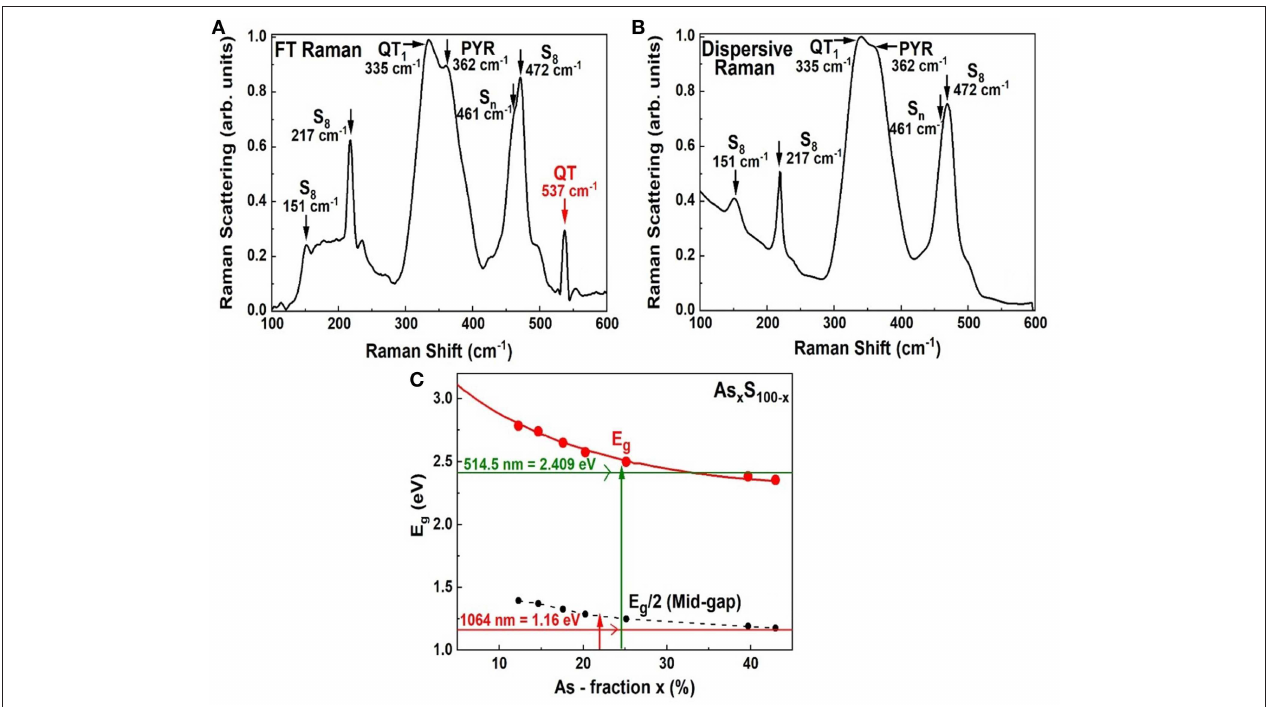
FIGURE 10 | Showing (A) FT—Raman spectrum of an As 18 S 82 glass as in Figure 4F , (B) a Dispersive Raman spectrum of the same glass, and (C) the variation of the optical band gap in As x S 100 − x glasses reported by Yamaguchi (1985). In (A) the scattering is excited in the midgap region using the 1,064nm as shown in (C) , while in (B) the scattering is excited using 514nm radiation that excited the scattering in the conduction band region.